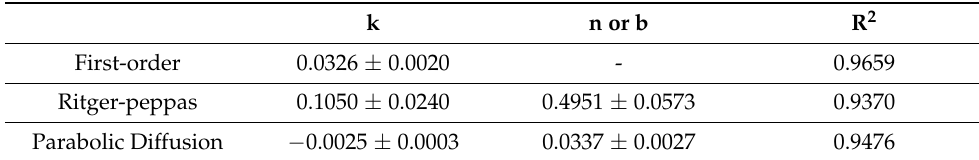
Figure 2. ( A ) The RR of FA from OACT@ASO in water at 30 °C with inset of the digital photographs (a) before and (b) after FA release. Plots of different kinetic models for the release of FA from OACT@ASO: ( B ) First-order, ( C ) Ritger-peppas, and ( D ) Parabolic Diffusion. Three-dimensional fluorescence spectra of ( E ) deionized water and ( F ) the release aqueous solution of OACT@ASO. Table 1. Kinetic fitting parameters of FA from OACT@ASO in